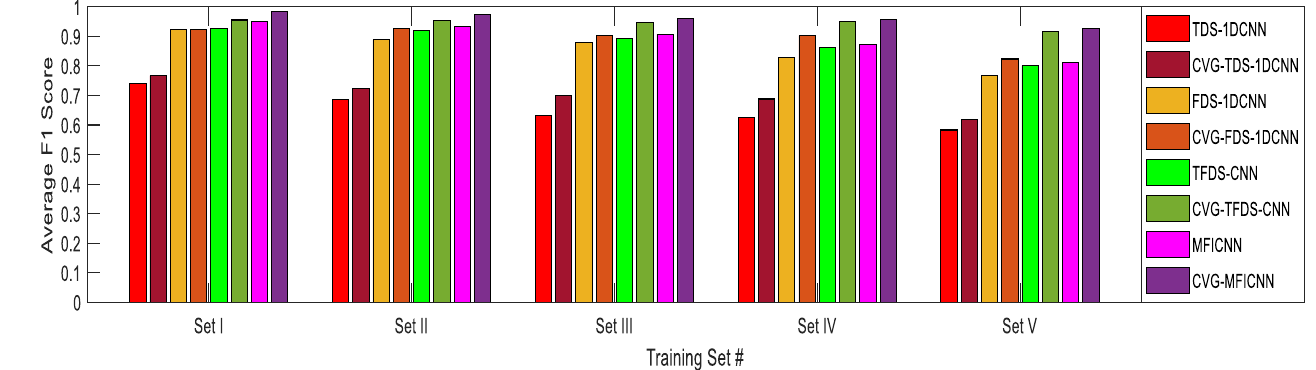
Figure 15. Comparison of average testing F1 scores of models trained using different methods and based on different training sets.